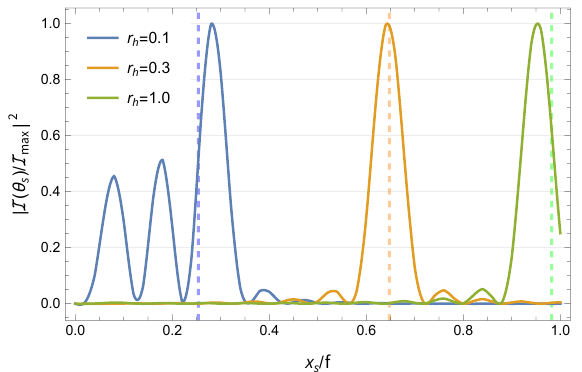
Figure 11 . The r h dependence of a cross-section view of the image for a vector-mode perturbation. Each dashed line represents a photon sphere radius calculated from the geodesic